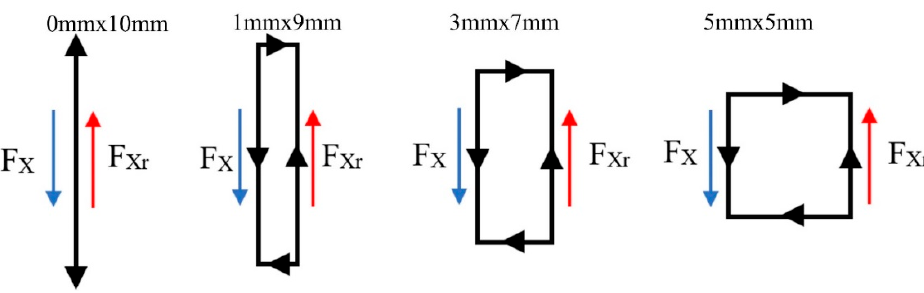
Figure 15. Force directions considered for the different patterns. Black arrows represent the sliding direction. and dividing appropriately.